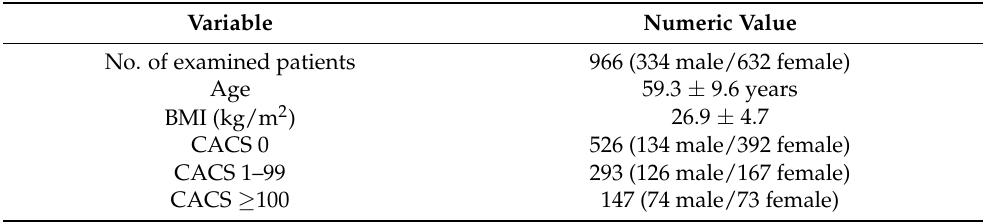
Table 1. Patient characteristics itemized by age, gender, BMI and Coronary Artery Calcium Score (CACS)